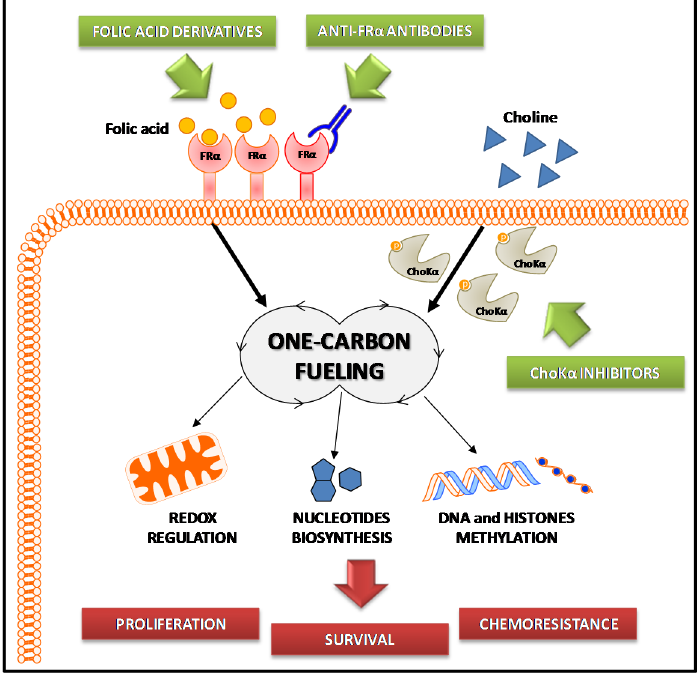
Figure 2. Scheme of the involvement of one ‐ carbon metabolism in epithelial ovarian cancer (EOC). The folic acid and choline metabolisms are deregulated in EOC due to overexpression of the alpha isoform of the folate receptor (FR α ) and hyperactivation of choline kinase alpha (ChoK α ), respectively. Allowing cell proliferation, chemoresistance, and survival (red rectangles), these processes contribute to EOC transformation and aggressiveness. Strategies targeting alterations in folate and choline metabolism (green rectangles) may, thus, be promising alternative approaches to treat EOC.